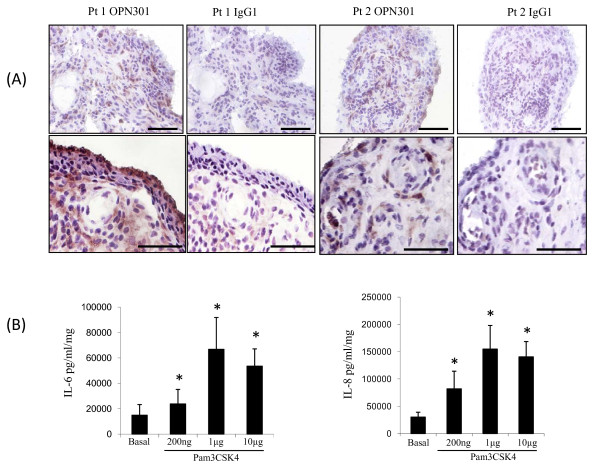
TLR2 expression is localized to the perivascular region and lining layer. (A) Two representative photomicrograph (Pt 1 and Pt 2) of RA synovial tissue of 10 patients stained for TLR2 expression. Expression is localized to the perivascular region and to the lining layer, with no staining observed for matched IgG control. The bar on the lower right hand corner of each photomicrograph represents a distance of 100 μm on the top panel and 50 μm on the bottom panel. (B) RA synovial tissue explant cultures were stimulated with TLR2 angonist Pam3CSK4 at 200 ng, 1 and 10 μg/ml. Levels of IL-6 (n = 11) and IL-8 (n = 8) in the culture supernatants were determined after 24 hrs. Values are expressed as the mean ± SEM. * P < 0.05 significantly different from control as determined using Wilcoxon Signed Rank analysis.